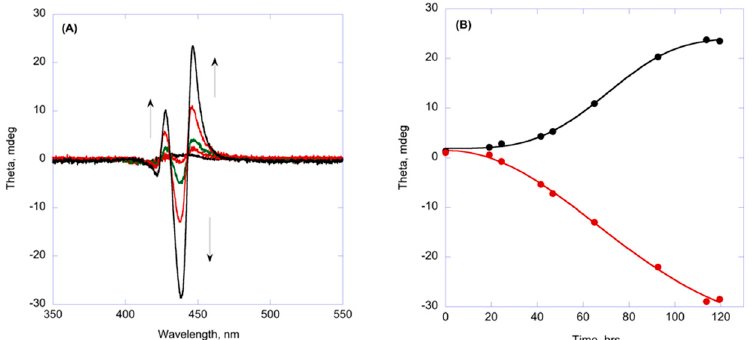
Figure 3. ( A ) CD spectral changes (Type-II aggregates evolution) with time of ( L )ZnP(-) 5 µ M (EtOH / H 2 O 25:75 v : v ) in the presence of ( S )-1-phenylethanamine 5.0 × 10 − 4 M. ( B ) Corresponding calculated fit (Equation (1)) at the wavelength maxima of the lower energy bands: λ = 446 nm (black circles); λ = 438 nm (red circles).